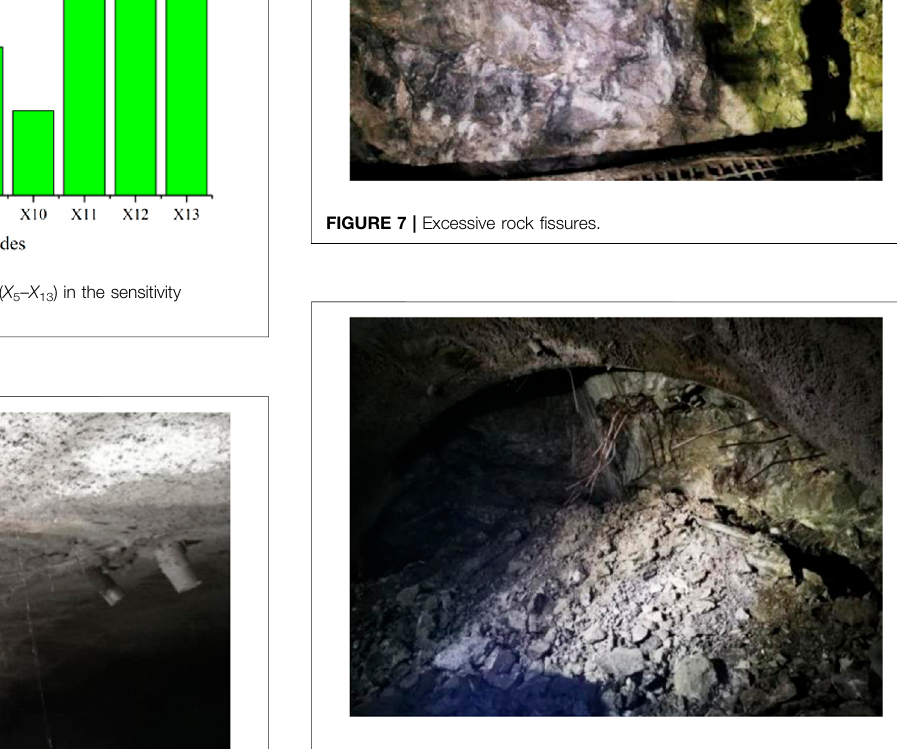
FIGURE 8 | Tunnel collapse.